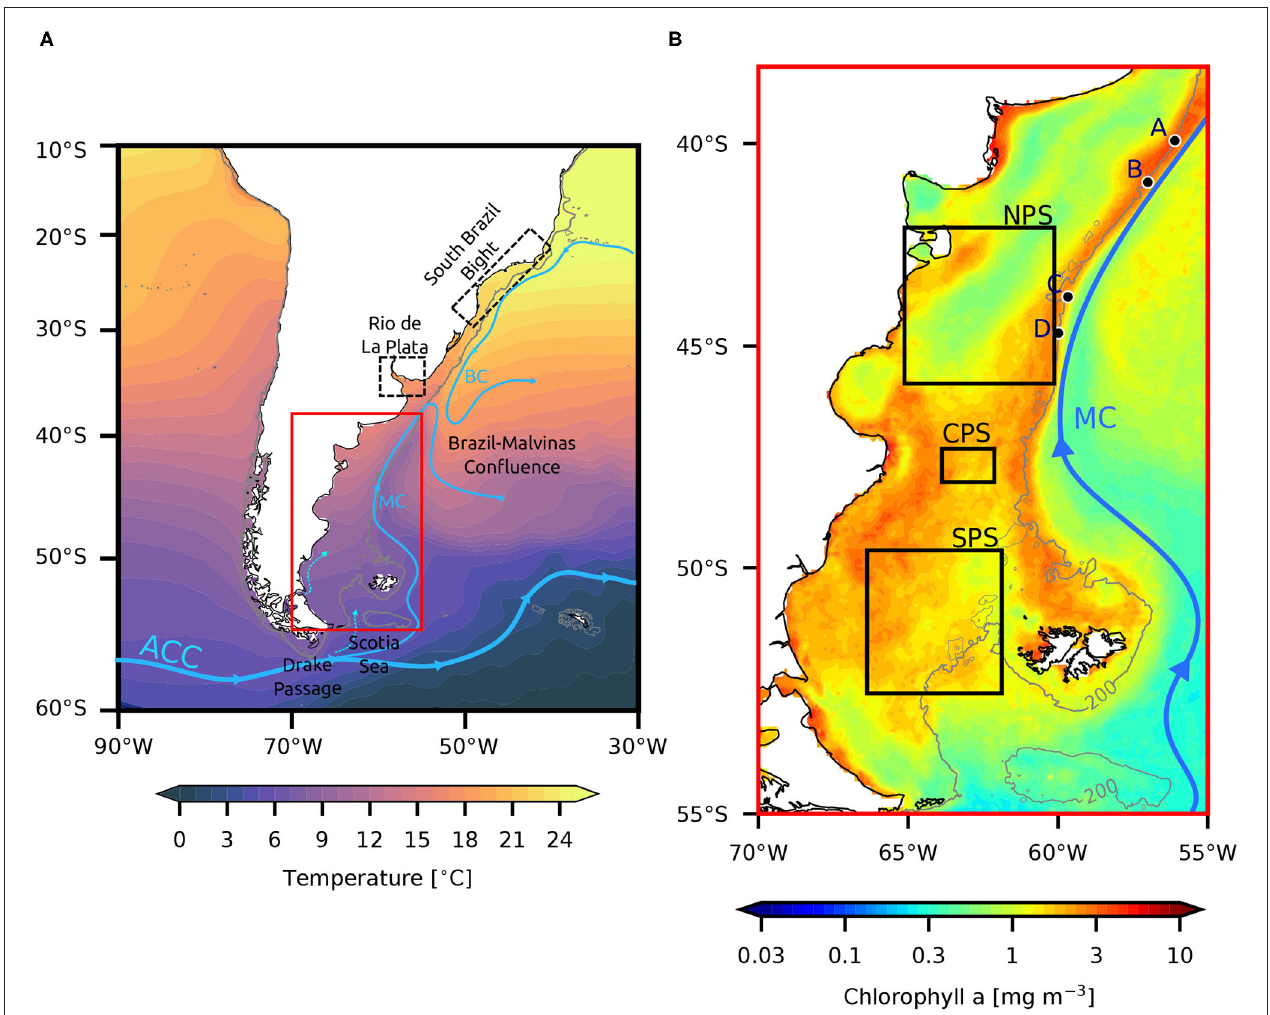
FIGURE 1 | (A) Distribution of climatological SST between 1982 and 2017 (see Section 2.1). Overlaid light blue arrows represent the schematic circulation of the Antarctic Circumpolar Current (ACC), Malvinas Current (MC) and Brazil Current (BC), based on the climatological MDT (1993–2012) from AVISO. (B) Climatological austral summer chlorophyll-a surface distribution (2002–2017) derived from MODIS aqua with 9 km spatial resolution. Also shown is the 200 m isobath (solid gray line, data from ETOPO1). Black dots (Sites A to D) are buoy locations of in-situ wind measurements (see also Table 2 ). Black rectangles indicate from North to South the main regions analyzed in this study: Northern Patagonian Shelf (NPS), Central Patagonian Shelf (CPS), and Southern Patagonian Shelf (SPS) (see Section 3.2, Table 3